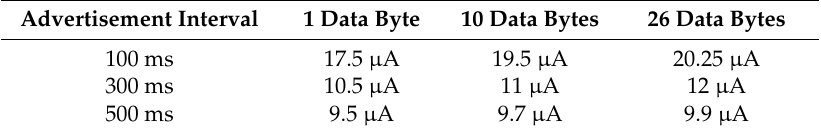
Table 2. Sensor current consumption for different packet sizes and advertisement intervals.